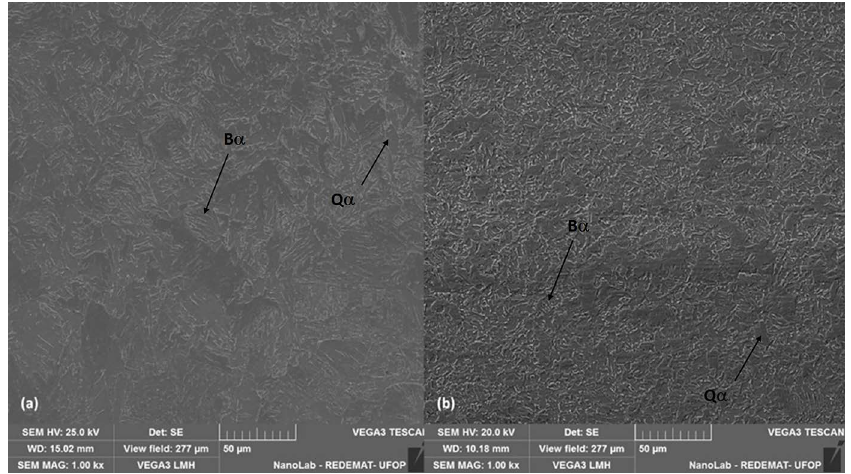
Figure 11. SEM micrographs of microstructures of (a) steel A and (b) steel B cooled with 100ºC/s - 1000X (Qα- quasi-polygonal ferrite and Bα- bainitic